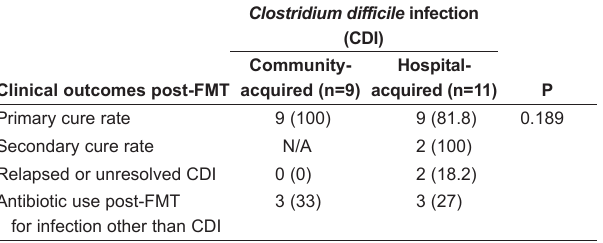
TAble 4 Comparison of clinical outcomes post-fecal microbiota transplantation